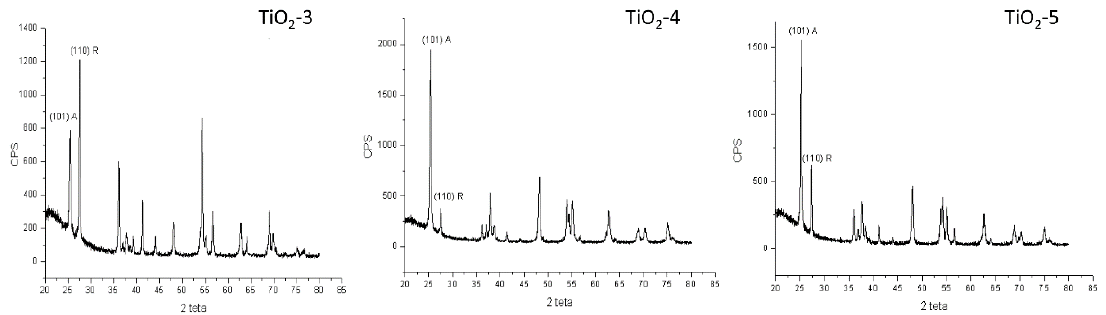
Figure 4. XRD patterns for samples TiO 2 -3, TiO 2 -4, and TiO 2 -5 with the main peak for both phases.